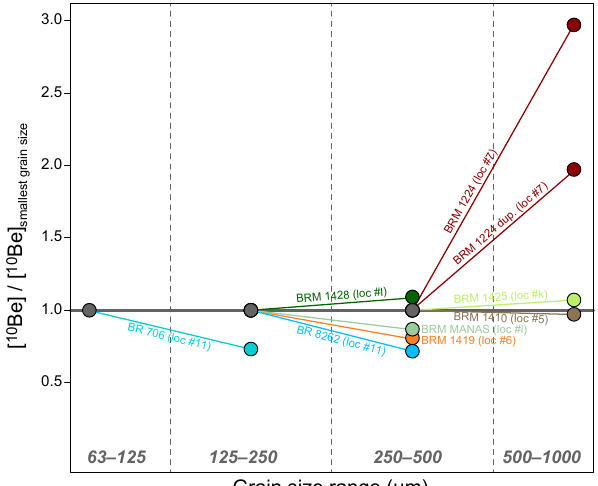
Figure 2. Ratio of 10 Be concentrations from grain size pairs of the same sediment sample. Concentrations are normalized to the con- centration of the lowest grain size fraction for comparison amongst